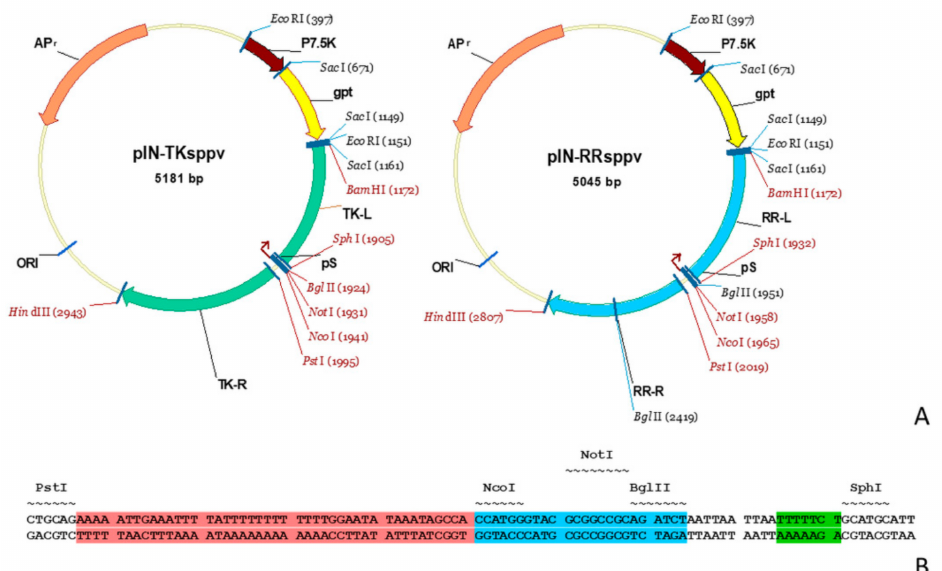
Figure 1. Scheme of DNA plasmid used for the generation of SPPV recombinants. ( A ) pIN-TKsppv and pIN-RRsppv. The vectors consist of the SPPV thymidine kinase (TK) (or ribonucleothide reduc- tase, RR) gene disrupted by synthetic sequence (foreign gene expression cassette), the Escherichia coli gpt dominant selectable marker gene under control of the camel pox virus P7.5K early/late promoter, and the ampicillin resistance gene (APr). Arrows indicate the direction of genes transcription. ( B ) Foreign gene expression cassettes consist of synthetic early/late promoter pS (pink), multiple cloning site (blue), stop-codons (white), transcription terminator (green). A multiple cloning site allows for insertion of immuno-protective genes under control of the synthetic early/late promoter